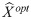
The logic of Accuracy Maximization Analysis.A Factors that determine the optimal non-linear decoder, g(⋅). For any particular filter set, the optimal decoder provides a closed form expression for the cost by i) computing the posterior probability over the latent variable p(X|R), and ii) reading out the optimal estimate X^opt from the posterior that minimizes the cost. B AMA begins with a labeled training set. Each individual stimulus in the training set, sij, must be labeled with a particular value of the latent variable of interest, Xi. The labeling of the training set implicitly defines the task. Subsequent steps to finding optimal task-specific filters via AMA are: i) select a particular stimulus skl from the labeled training set; ii) obtain a noisy filter response Rkl from a given (possibly non-optimal) set of initial filters; iii) use the optimal non-linear decoder to obtain the optimal estimate and its expected cost; iv) repeat for each stimulus in the training set and compute the average cost across the training set; v) update the filters to reduce the cost; vi) repeat until the average cost across the training set is minimized. The filters that minimize the cost are the optimal task-specific filters.